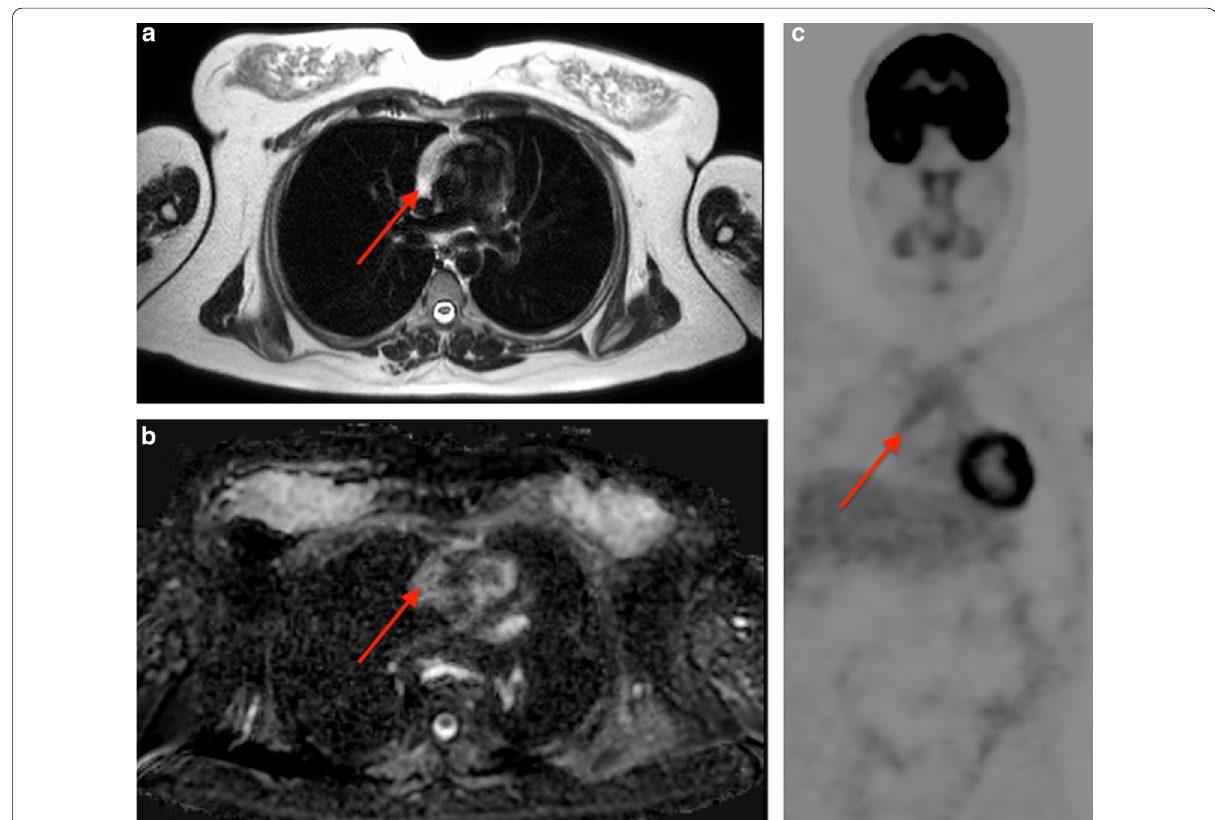
Fig. 4 25-years-old female affected by HL with anterior mediastinal residual mass after therapeutic treatment. T2-weighted images showed an hyperintense tissue a which presented also a mild hyperintensity on apparent diffusion coefficient (ADC) map (ADC: 1.6 18F-FDG- PET/CT showed moderately increased metabolic activity (SUV max : 4.7) ( c ). Biopsy demonstrated no disease